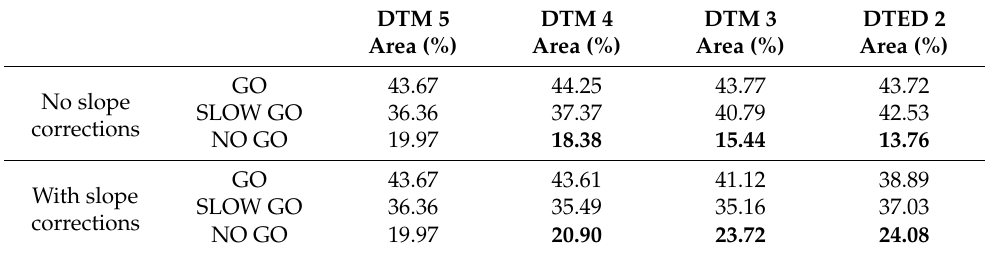
Table 7. The comparison of the extent of passable, hardly passable, and impassable areas with different elevation models without slope corrections and with slope corrections. Location: Doln í Morava, 3 km × 3 km, moist conditions, GO max slope = 10 ◦ , SLOW GO max slope = 20 ◦ . The main improvements in the results are displayed as bold